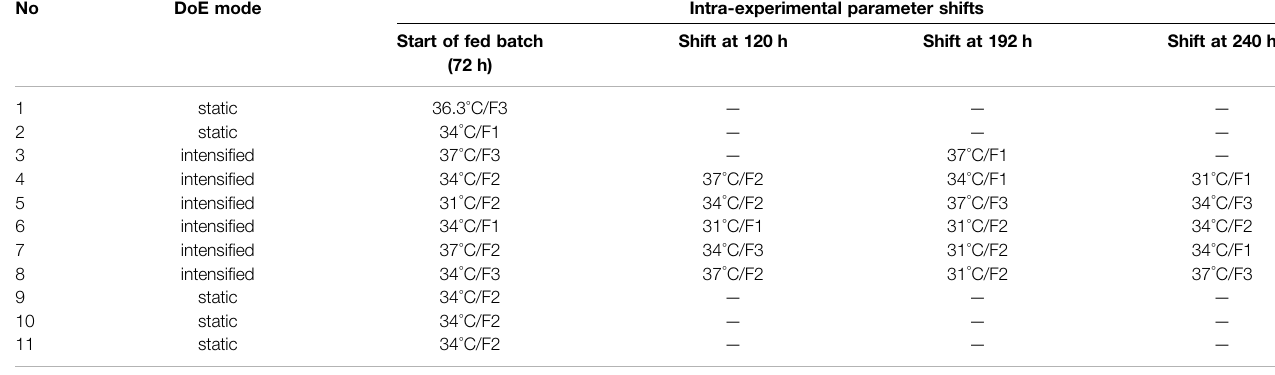
TABLE 2 | Used parameters and time points of CPP shifts in iDoE experiments in 15 L stirred-tank bioprocesses.